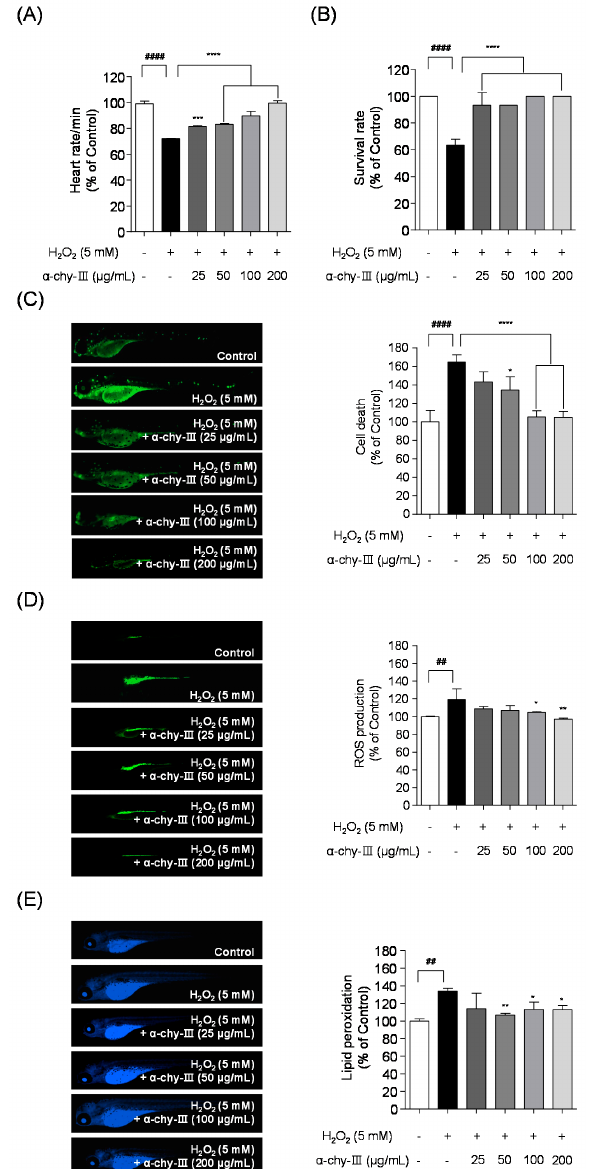
Figure 5. Effect of α -chy-III on H 2 O 2 induced oxidative stress in survival rate ( A ), heart rate ( B ), cell death ( C ), ROS generation ( D ), and lipid peroxidation ( E ) in zebrafish embryos. Levels of fluorescence intensity were calculated using ImageJ software. Experiments were performed in triplicate and data are expressed as mean ± SD; Significant differences identified at * p < 0.05, ** p < 0.01, *** p < 0.001 and **** p < 0.0001 as compared to the H 2 O 2 treated group; ## p < 0.01 and #### p < 0.0001 as compared to the control group. Statistical analyses were conducted using Tukey’s post hoc comparison and Duncan’s multiple